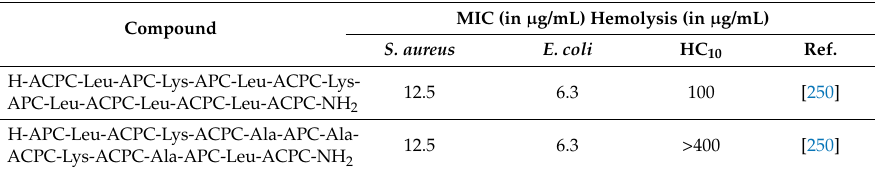
Table 7. Antimicrobial and hemolytic activity of representative α -peptide/ β 3 -peptide